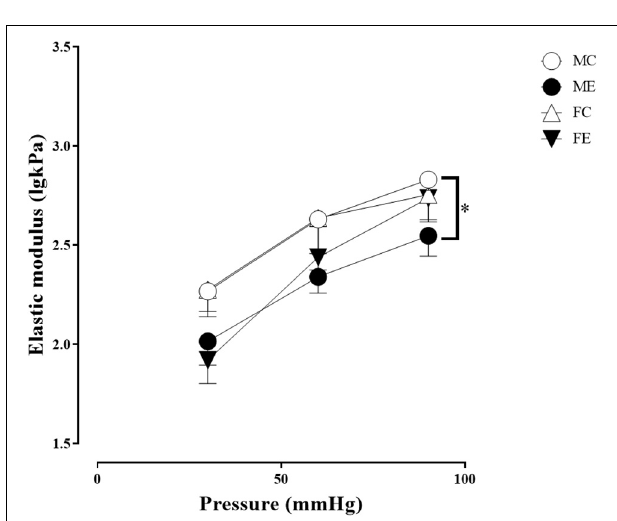
FIGURE 3 | Tangential elastic modulus as a function of intraluminal pressure measured in passive conditions of the gracilis muscle arterioles from the MC, ME, FC, and FE animals. As a result of the exercise, the elastic modulus was significantly smaller in the ME rats than in the MC rats. The data are expressed as the mean (SEM) values. The significance levels of the two-way ANOVA and Tukey’s post hoc tests between the four groups are shown. ∗ P < 0.05 MC vs. ME.